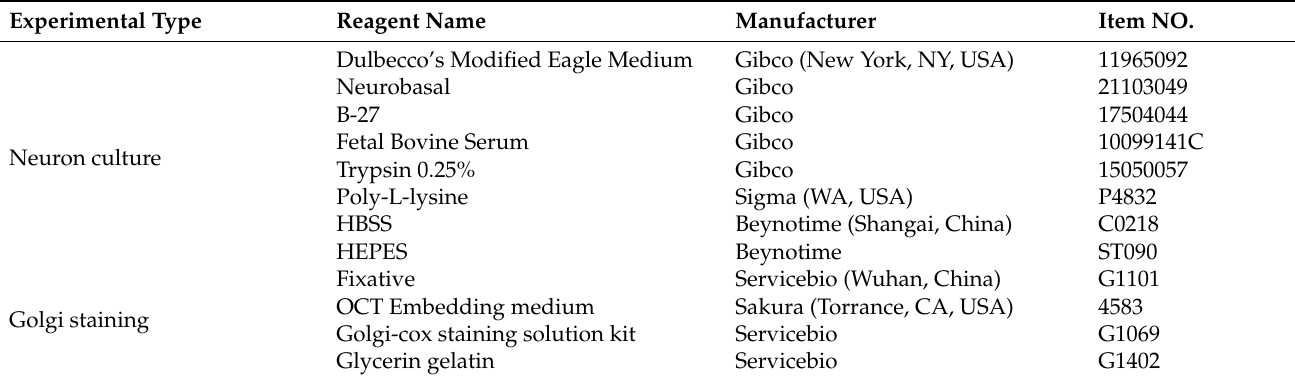
Figure 1. ( A ) Experimental platform for terahertz radiation cortical neurons. ( B ) Protocol for Terahertz Cumulative Radiation Neurons. The neurons were extracted and cultured in vitro for the first two days of the experiment. Waiting for the neurons to grow against the wall, the neurons were subjected to cumulative radiation for 3 days, 20 min/day. ( C ) Absorption characteristics and temperature variation patterns of the terahertz waves by neuronal culture fluid. ( D ) No significant difference in neuronal mortality in the Petri dishes after three days of terahertz cumulative radiation of the neurons. Data are mean ± SEM ( n = 10 independent experiments). Independent samples t -test, n.s. indicates no significant difference. Table 1. Main reagents required for cortical neuron